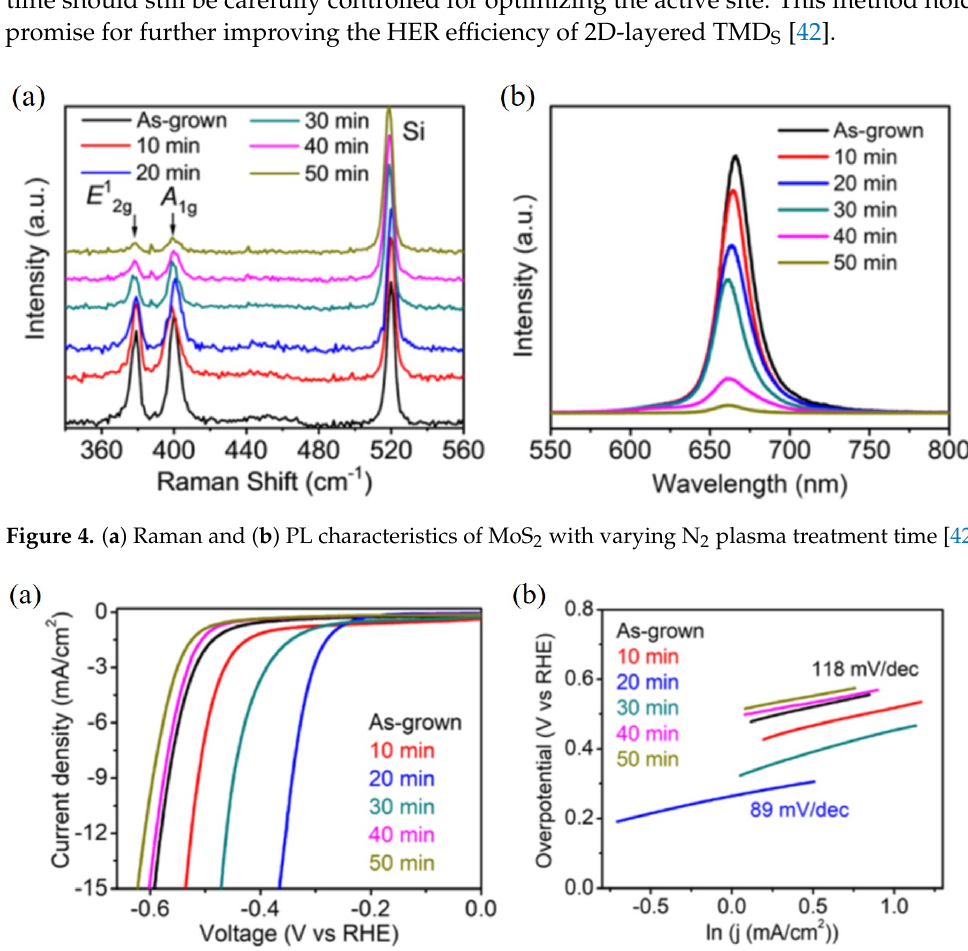
Figure 5. ( a ) iR-corrected linear sweep voltammograms and ( b ) Tafel plots with varying N 2 plasma treatment time [42].